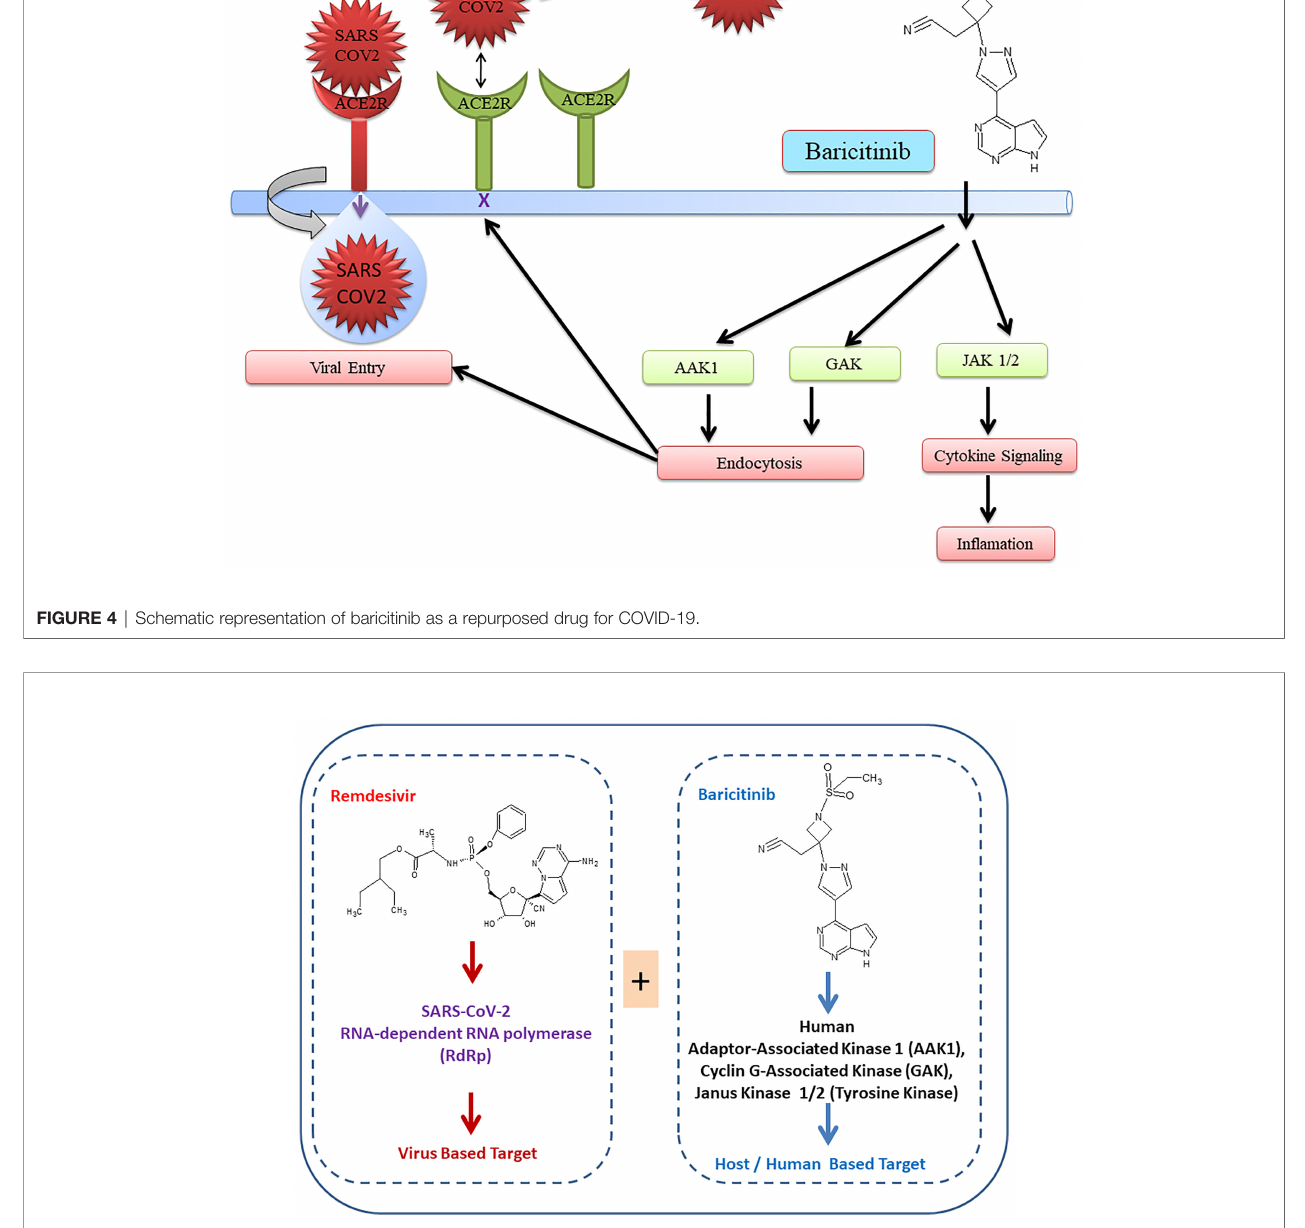
FIGURE 5 | Simultaneous targeting of virus enzyme by remdesivir and human kinase by baricitinib.